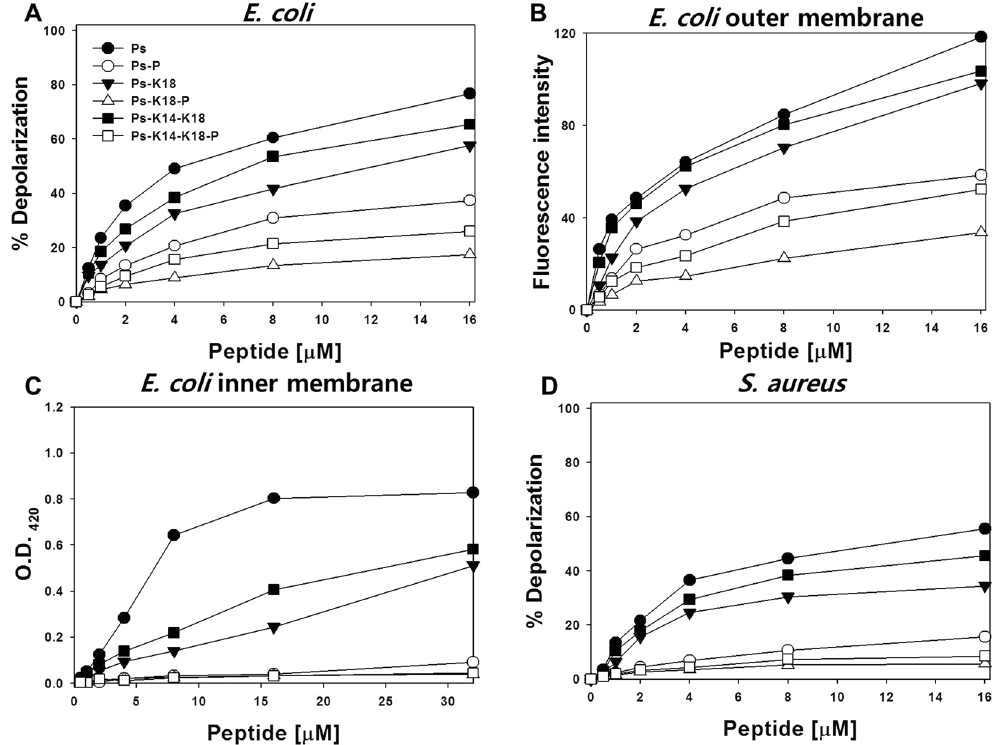
Figure 4. ( A ) Concentration-dependent membrane depolarization of intact E . coli KCTC 1682, monitored as an increase in diSC 3 -5 fluorescence. ( B ) Permeabilization of the outer membrane of E . coli KCTC 1682 monitored as an increase in NPN fluorescence intensity. ( C ) Permeabilization of the inner membrane of E . coli ML35p monitored as hydrolysis of ONPG by β -galactosidase. ( D ) Membrane depolarization of S . aureus KCTC 1621, monitored as an increase in diSC 3 -5